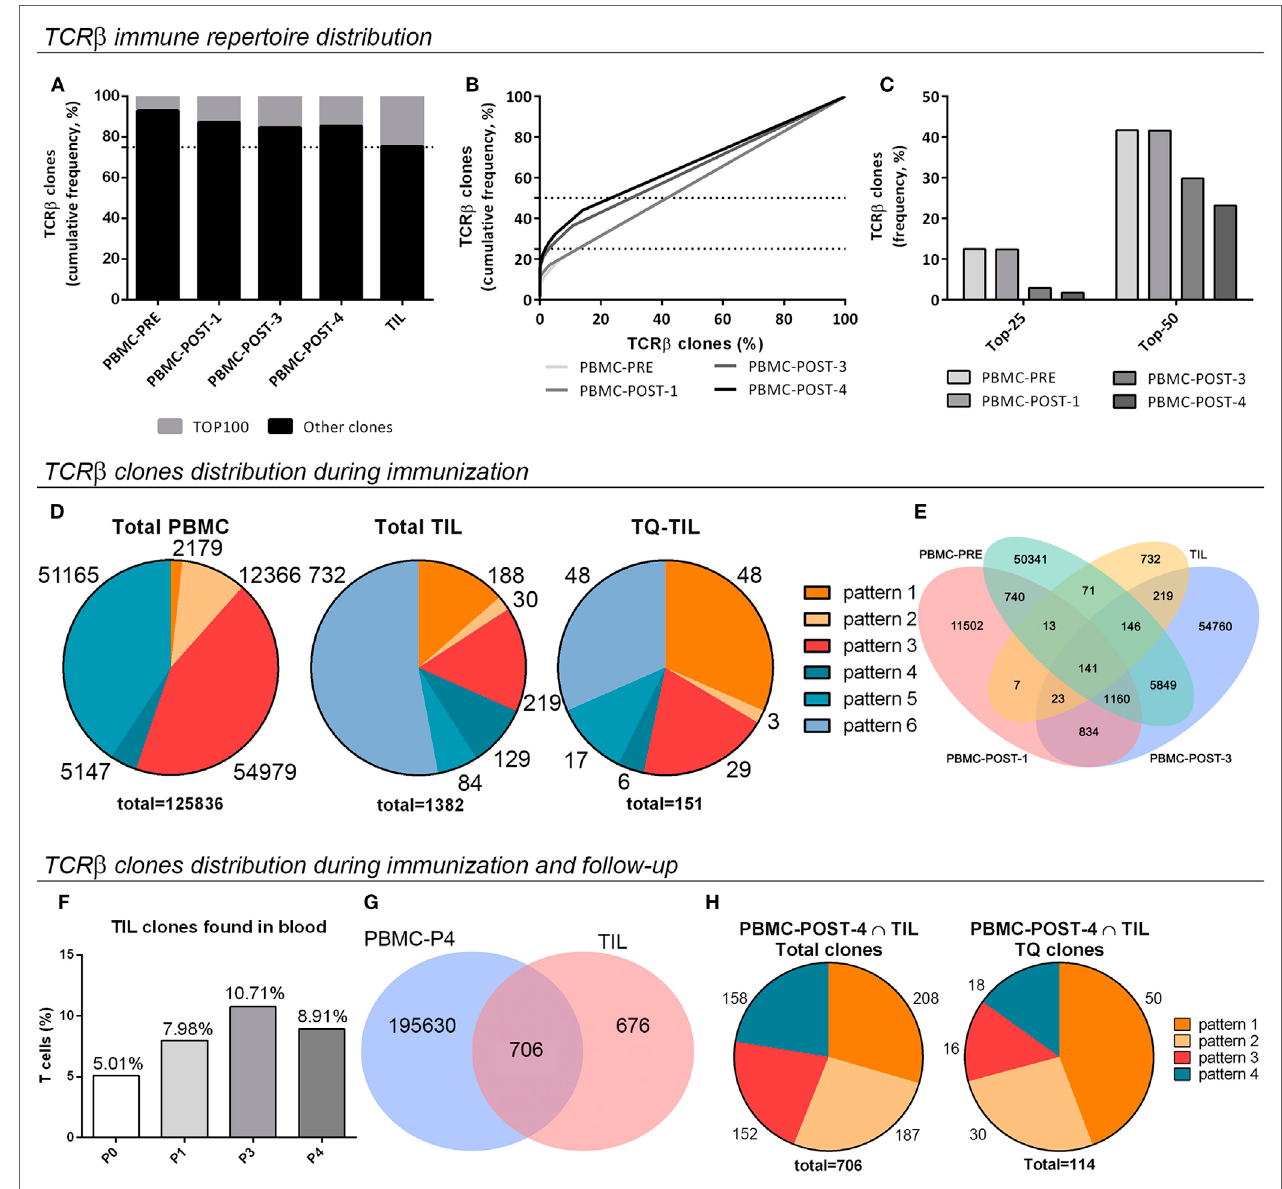
FIGURe 3 | Distribution and tracking of the T-cell receptor β (TCR β ) immune repertoire in peripheral blood mononuclear cells (PBMC) and subcutaneous metastasis from patient #006. (a) Percentage of total TCR β clones covered by the TOP100 clones, the 100 most frequent ones (nucleotide sequences). (B) Total TCR β clones (%), from highest to lowest, in function of their cumulative frequency (nucleotide sequences). (C) The proportion of TCR β clones (%) that constitute the TOP-25 or TQ clones, and the TOP-50 clones are shown (TOP-25/50, the proportion of clones that make up the top cumulative frequency of 25/50). (D) Pattern distribution of TCR β clones in total PBMC, total tumor-infiltrating lymphocytes (TIL), and Top-Quartile TIL (TQ-TIL); the number of clones for each pattern and total clones analyzed in each case is indicated. Patterns: 1, present at baseline, increases in time; 2, absent at baseline, increases in time; 3, absent at baseline, detected at POST-3 sample; 4, present at baseline, decreases in time; 5, present at baseline, absent in time; and 6, absent at blood, present in tumor. (e) Common sequences among PBMC-PRE, PBMC-P1, PBMC-P3, and TIL samples. (F) The proportion of TIL clones present in blood at different times. (G) Venn diagram illustrating common clones among TIL and POST-4 samples regarding amino acid sequences. (H) Distribution in tracking patterns of total and TQ-TIL clones shared with PBMC POST-4. Pattern 3: absent at baseline, detected at POST-4